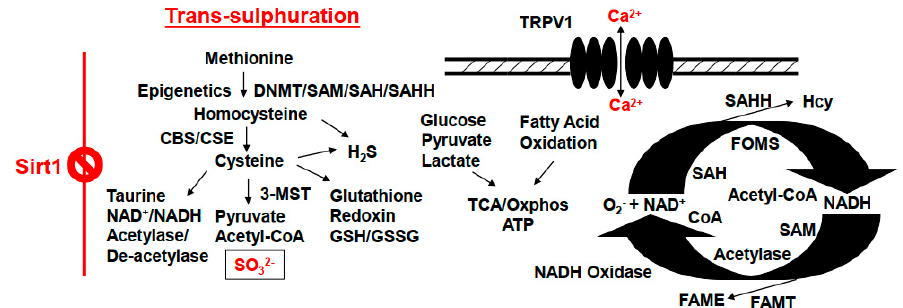
Figure 3. Defects in the epigenetics programming can lead to pathological outcomes by creating homocystinuria, dysregulation of mitochondrial bioenergetics, trans-sulfuration malfunctioning, formation of cysteine stones, and the onset of renal dysfunction. DNMT, DNA methyltransferase; CBS, cystathionine- β synthase; CSE, cystathionine- γ lyase; Oxphos, oxidative phosphorylation; TRPV1, transient receptor potential cation channel, also known as the capsaicin receptor and the vanilloid receptor 1; SAM, s-adenosyl-methionine; SAH, s-adenosyl homocysteine; SAHH, s-adenosyl homocysteine hydrolase; FAME, fatty acid methyl ester; FAMT, fatty acid methyltransferase; FOMS, folate 1-carbon metabolism methyl synthase; TCA, tricarboxylic acid/citric acid cycle.